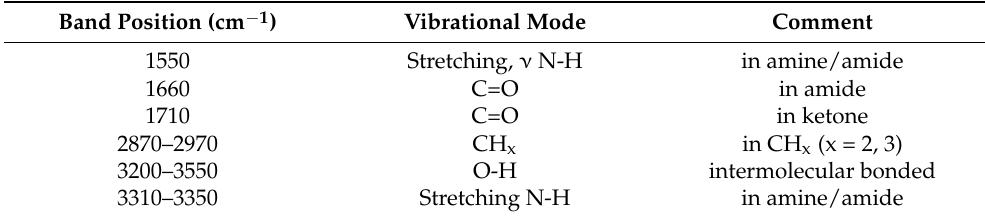
Table 3. Frequencies and assignments of the main absorption peaks found in the IR spectrum of plasma-coated ETFE samples